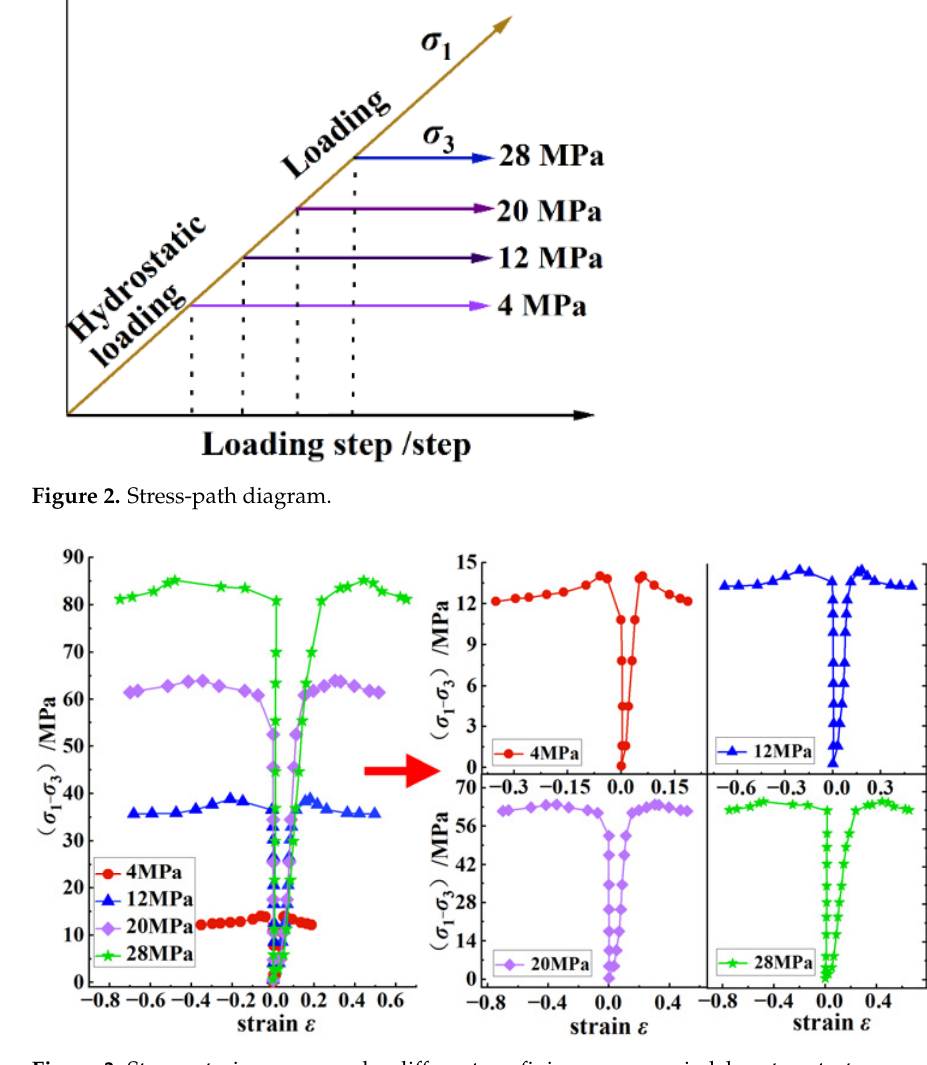
Figure 3. Stress–strain curves under different confining pressures in laboratory tests.